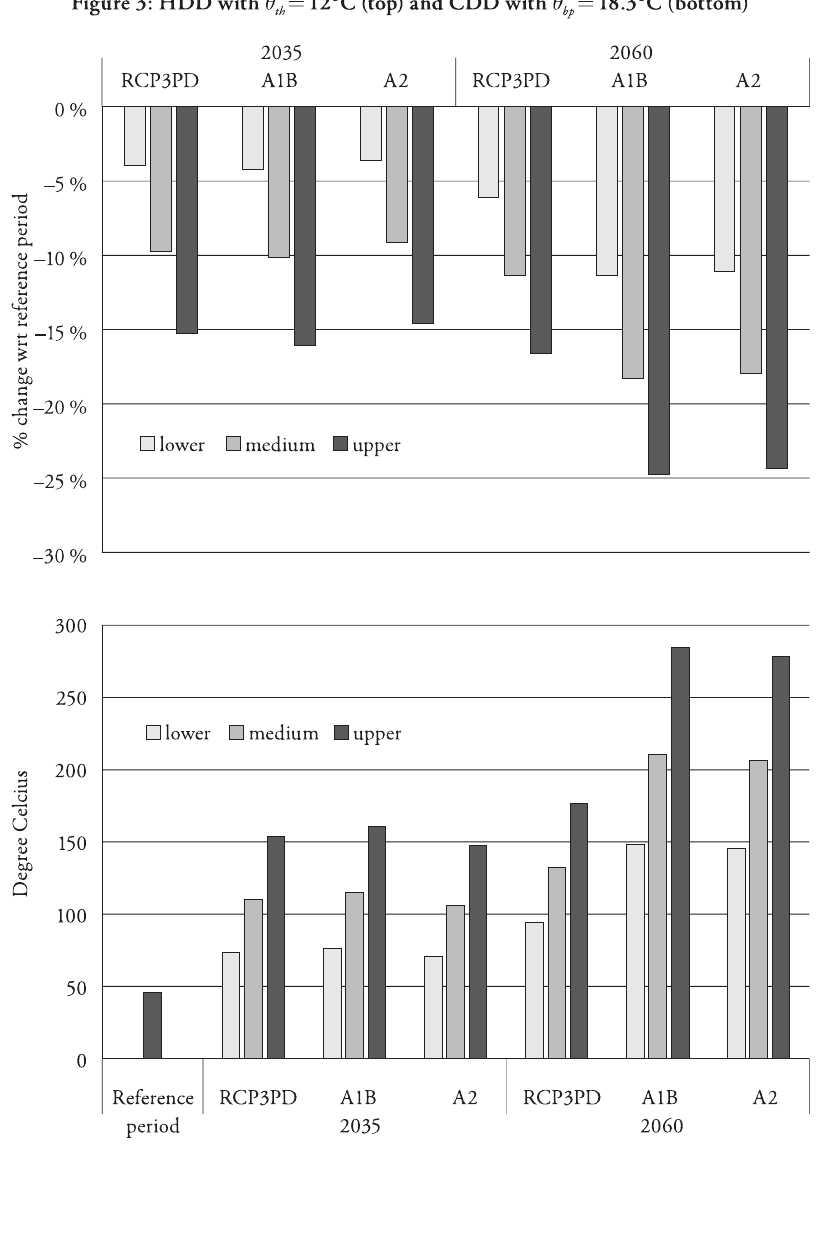
Figure 3: HOD with 8,.= l2°C (top) and COD with 8~= 18.3°C